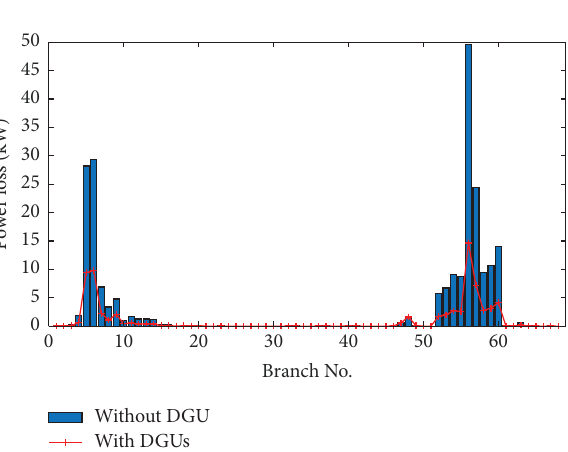
Figure 13: Power loss on distribution lines in IEEE 69-bus radial distribution system before and after placing DGUs.